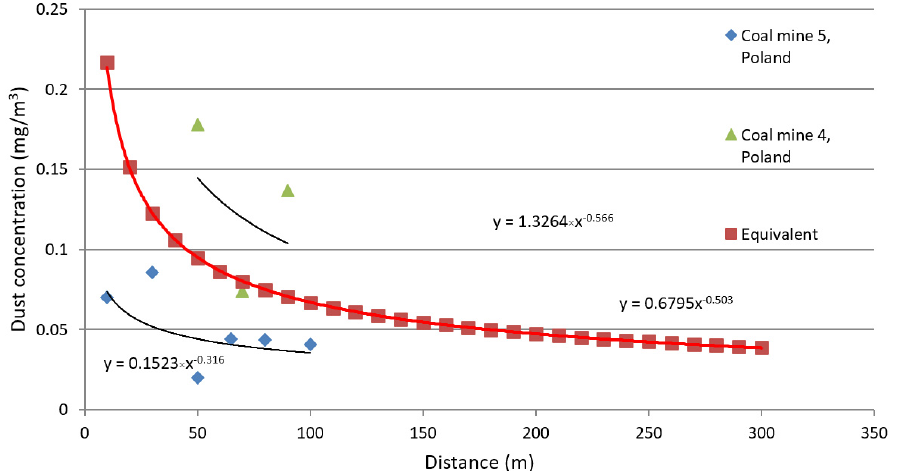
Figure 17. Equivalent characteristics of PM2.5 dust concentration (measured by IPSQ analyzer), depending on the distance from the dust source, were determined on the basis of dust measurements in two gates.